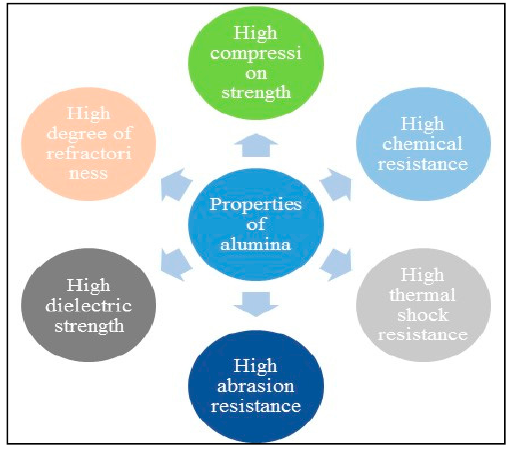
Figure 6. Properties of alumina nanoparticles.